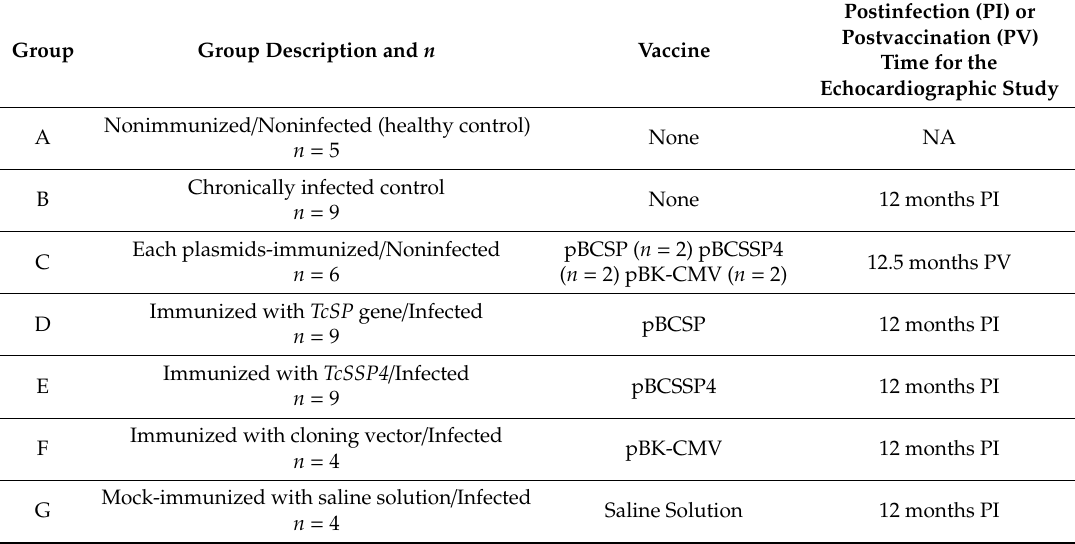
Table 1. Study design for T. cruzi experimentally infected dogs immunized with DNA vaccine containing the genes encoding a trans -sialidase protein (pBCSP) or an amastigote-specific glycoprotein